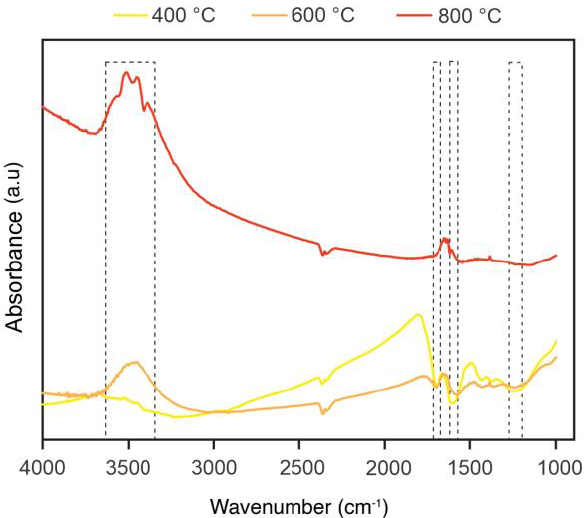
Figure 5. FTIR spectra of charcoal fines produced at different pyrolysis temperatures.